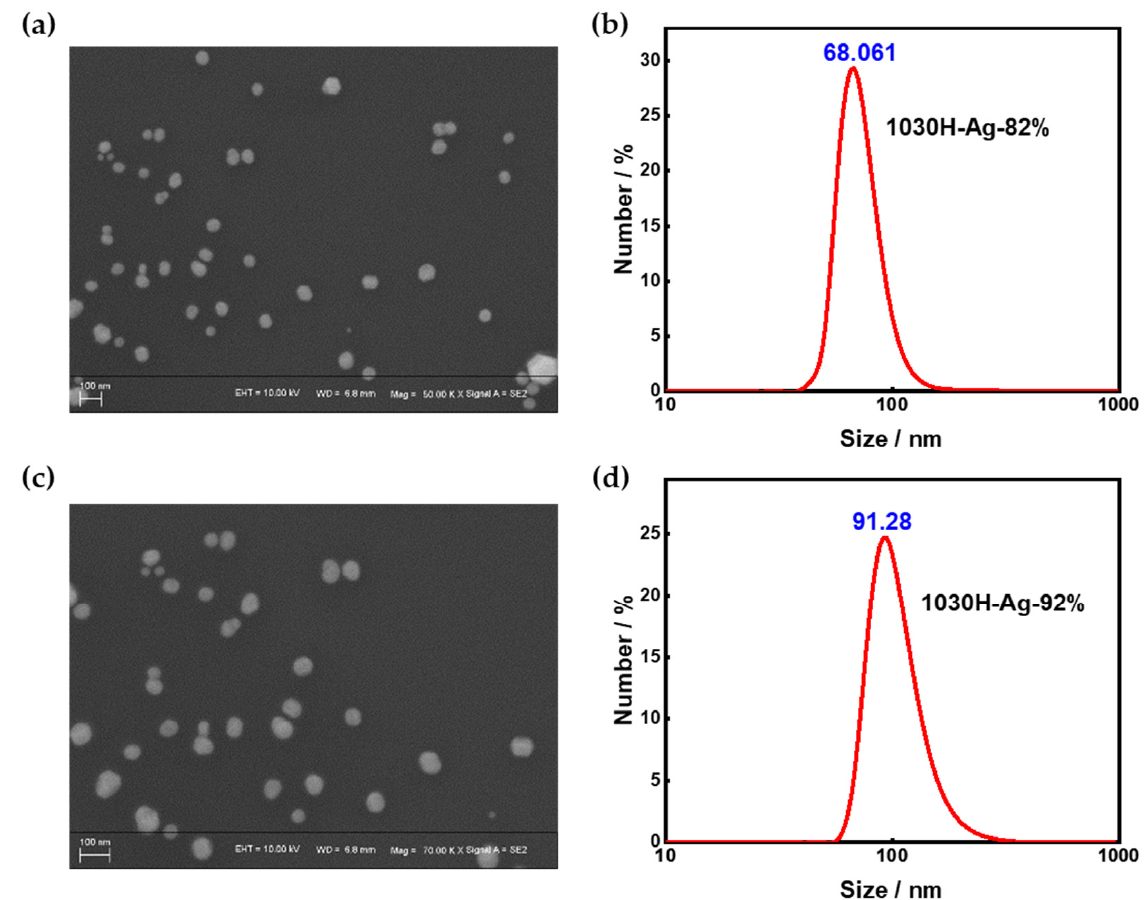
Figure 7. ( a ) SEM of 1030H-Ag-82% conductive ink; ( b ) Particle size distribution chart of 1030H-Ag-82% conductive ink; ( c ) SEM of 1030H-Ag-92% conductive ink; ( d ) Particle size distribution chart of 1030H-Ag-92% conductive ink. Figure 7c,d are the SEM image and particle size distribution of 1030H-Ag-92% conduc- tive ink. The particle size distribution of 1030H-Ag-92% conductive ink was also uniform, with a peak particle size 91.28 nm higher than that of 1030H-Ag-82% conductive ink. This is because the proportion of 1030H resin in 1030H-Ag-82% conductive ink is higher, and the effect of suppressing the aggregation of silver nanoparticles is more